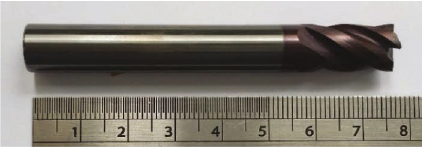
Figure 1: The cutting Table 1: Technical specifications of the cutting tool.